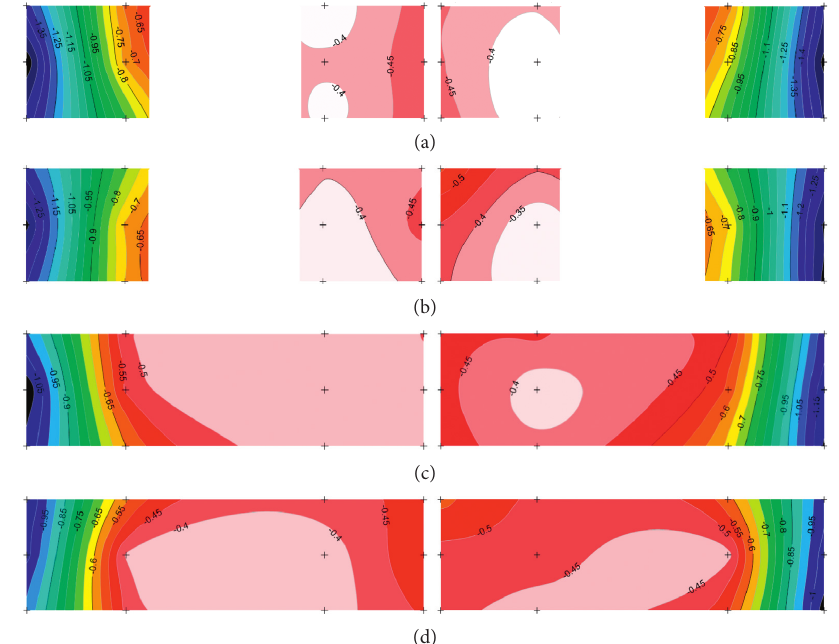
Figure 16: Mean wind pressure coefficients of wall AB in the x -direction. (a) Wall AB at the upper opening in the model of L-3 (expanding along the axis, the left side represents the A side (the flow flows from left to right); the right side represents the B side (the flow flows from right to left), the same below). (b) Wall AB at the lower opening in the model of L-3. (c) Wall AB at the upper opening in the model of L-2. (d) Wall AB at the lower opening in the model of L-2.